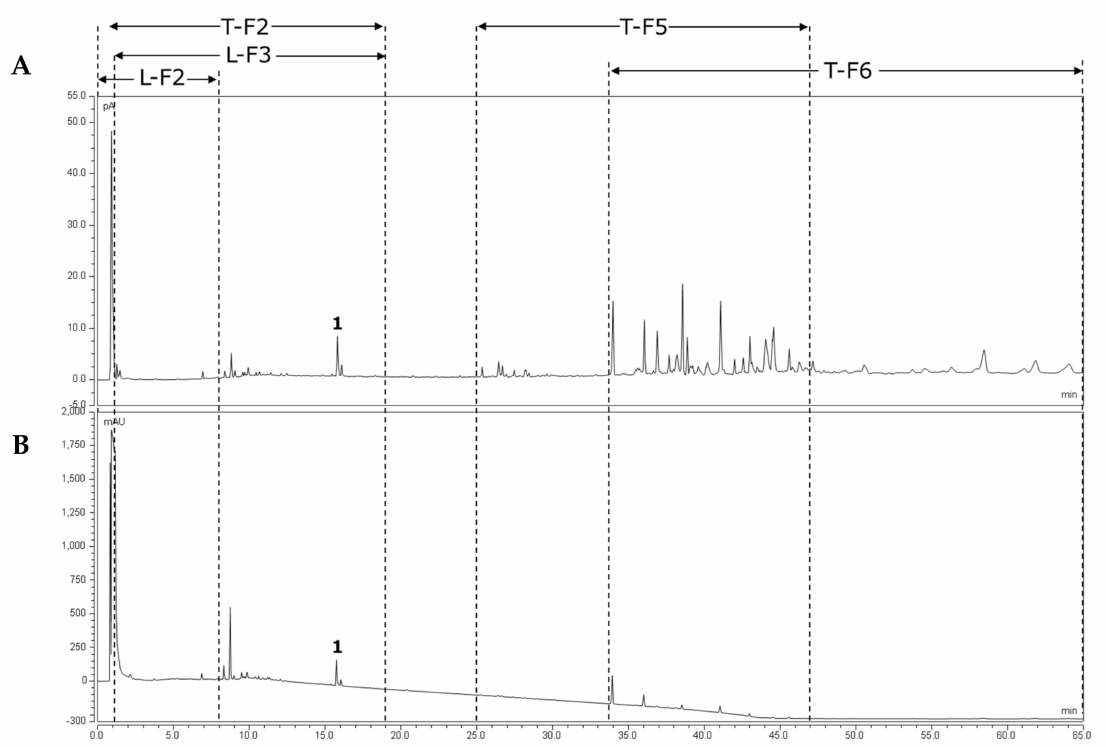
Figure 2. UHPLC chromatogram of Waltheria indica leaf extract E70 obtained at 70 ◦ C with ethanol; the dashed lines show the observed compounds of the respective CPC fractions with ( A ) CAD and ( B ) DAD at 200 nm. The signal ( 1 ) at Rt = 15.81 min corresponds to that of